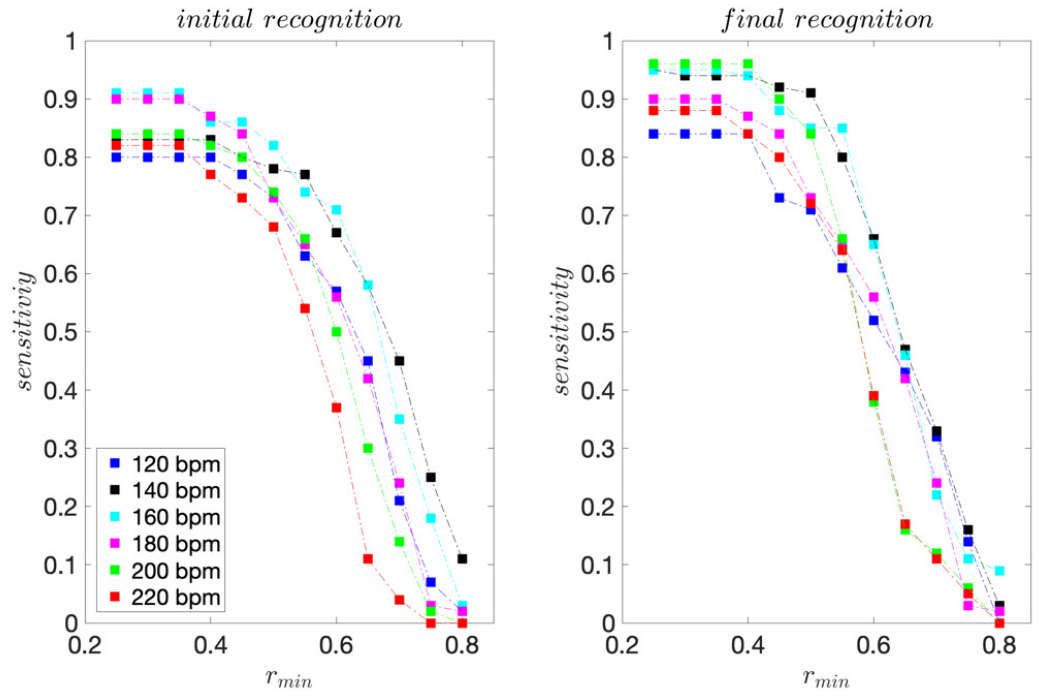
Figure 3. Sensitivity scores obtained for the professional dancer’s test sequences.